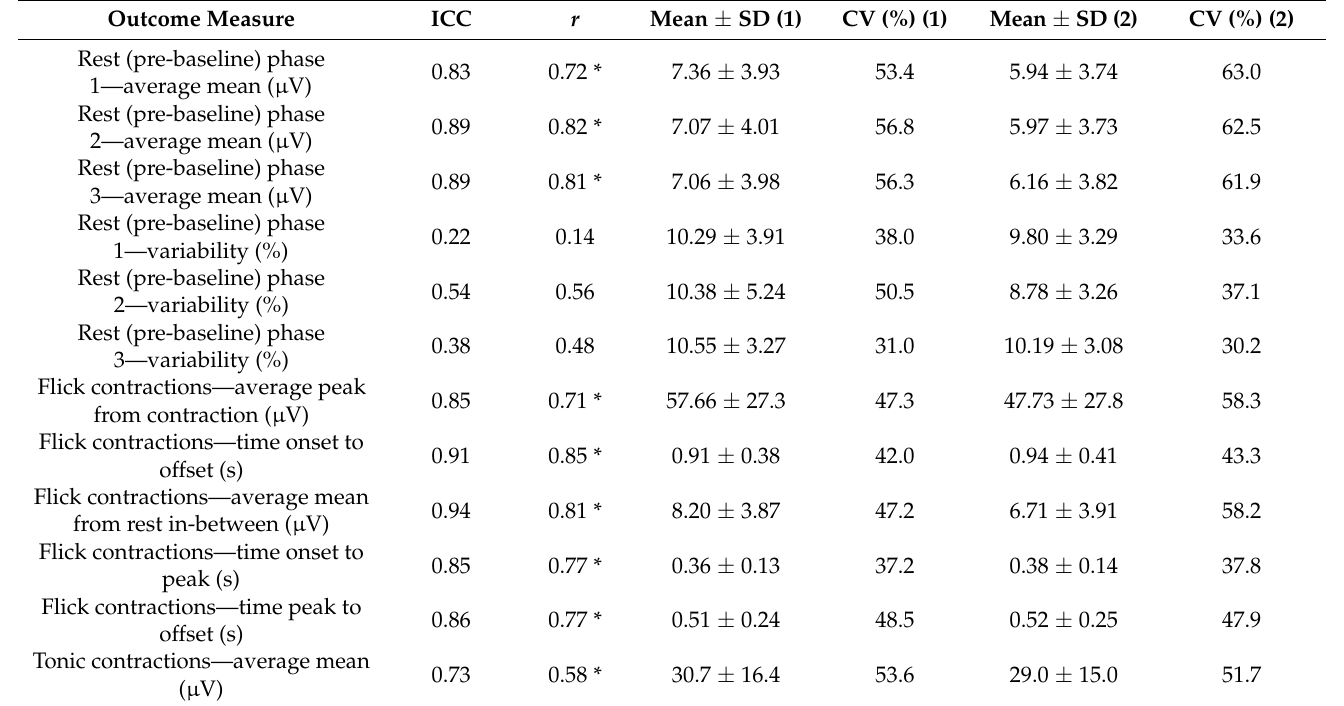
Table 3. Our multi-activity sEMG protocol between-trial